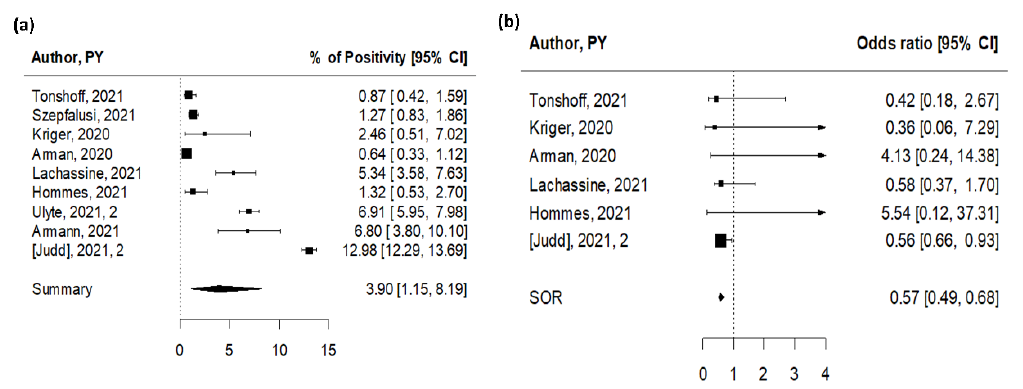
Figure 3. Pooled estimates for SARS-CoV-2 seroprevalence studies. ( a ) Pooled estimate of testing positive for antibodies for SARS-CoV-2. ( b ) Pooled estimate of odds of testing positive for antibodies for SARS-CoV-2 for children versus adults.